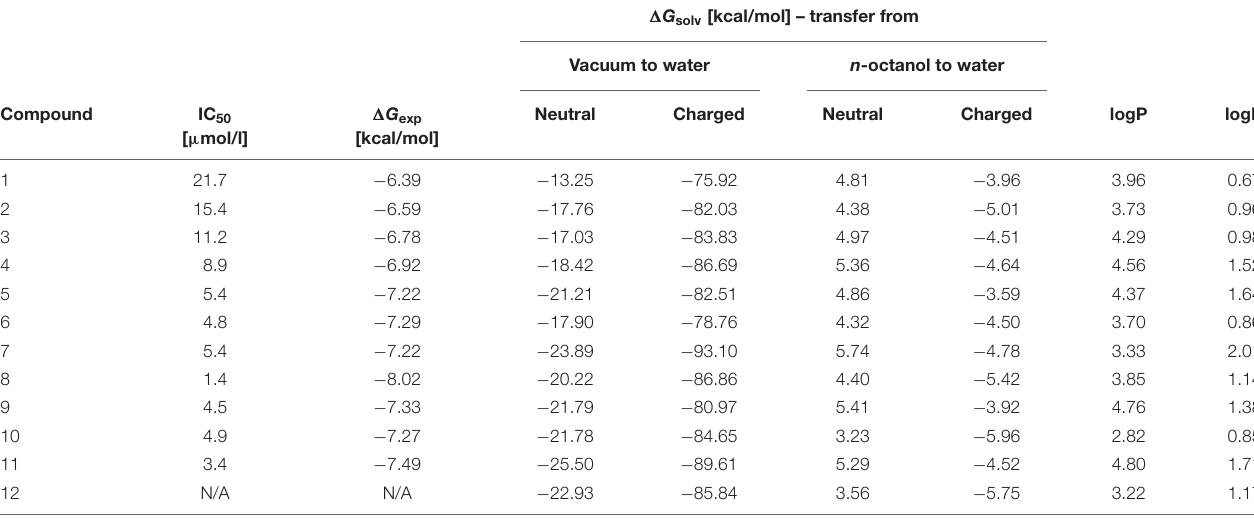
TABLE 2 | Summary of the computational values of the physicochemical properties of neuroactive steroids.